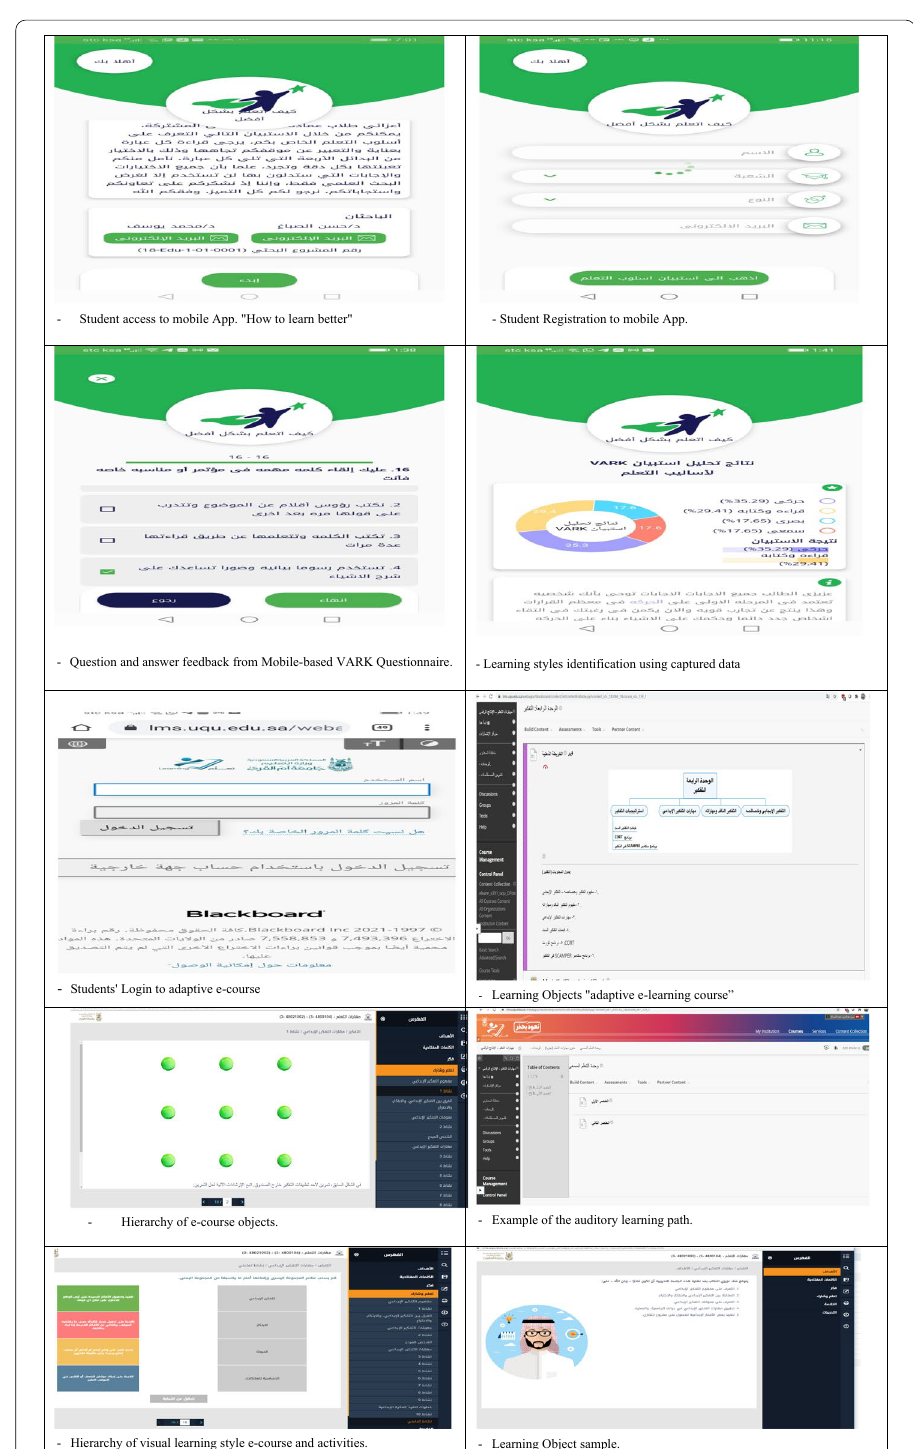
Fig. 8 Visual example from "learning of the learning styles" identification and adaptive e‑learning course